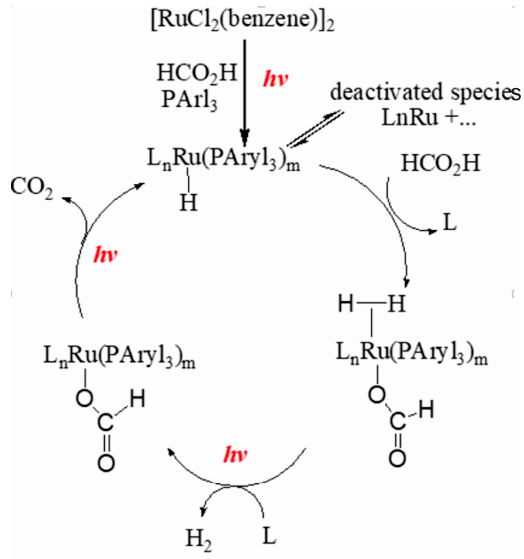
Figure 11. CatalyticcycleforFAdehydrogenationproposedbyBelleretal. withassistedmultiple-photons mechanism. Figure adapted from Reference